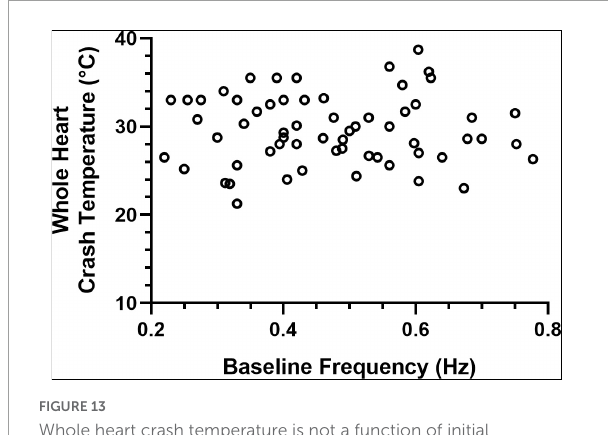
FIGURE13 Whole heart crash temperature is not a function of initial contraction frequency. Plot of 63 hearts showing the temperature at which each heart crashed as a function of the baseline contraction frequency of that heart. There is no correlation between the crash temperature in the absence of a modulator (control) compared to the baseline (8–10 ◦ C) contraction frequency of each heart (Spearman Rank Correlation test: ρ = 0.069, d = 0.54, p = 0.59; N =